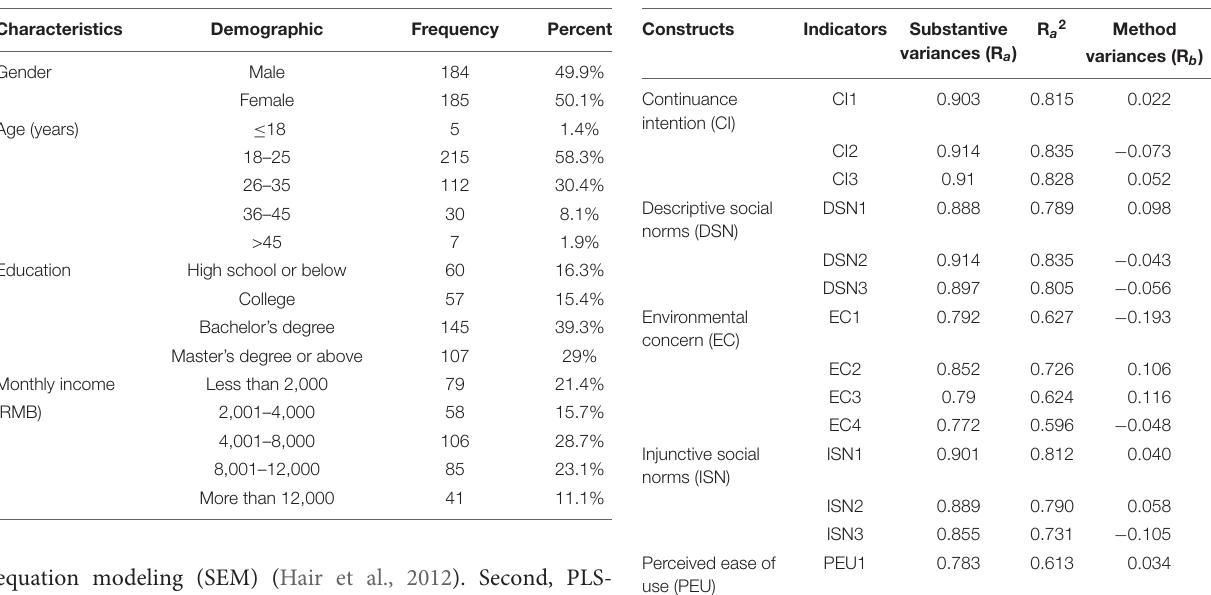
TABLE 1 | Sample demographics ( N = 369). TABLE 2 | Common method bias